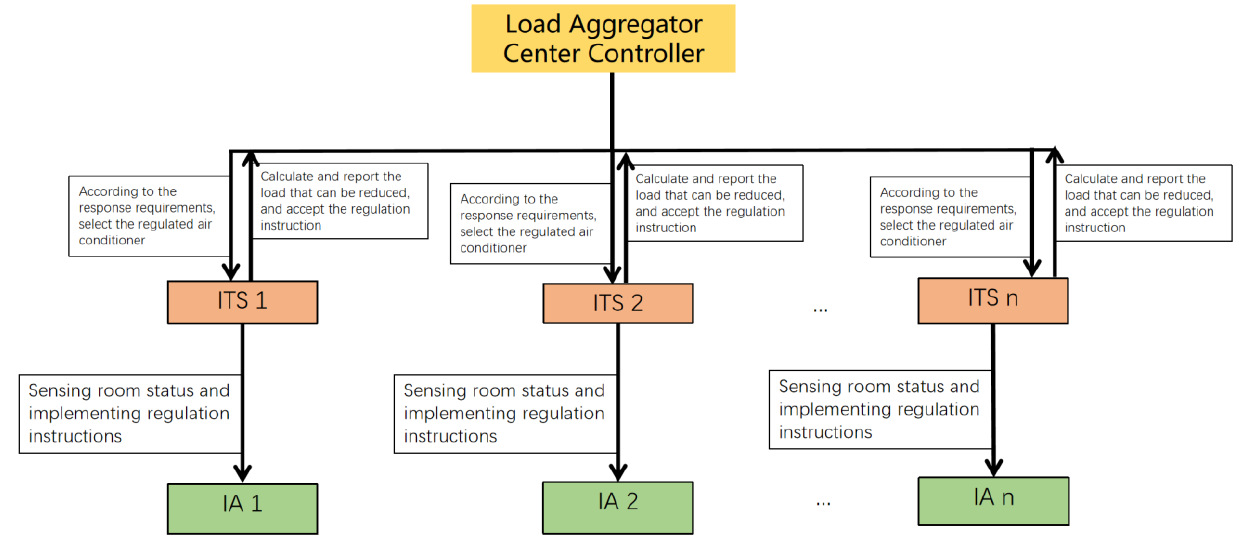
Figure 4. Settings of AC intelligent terminal.